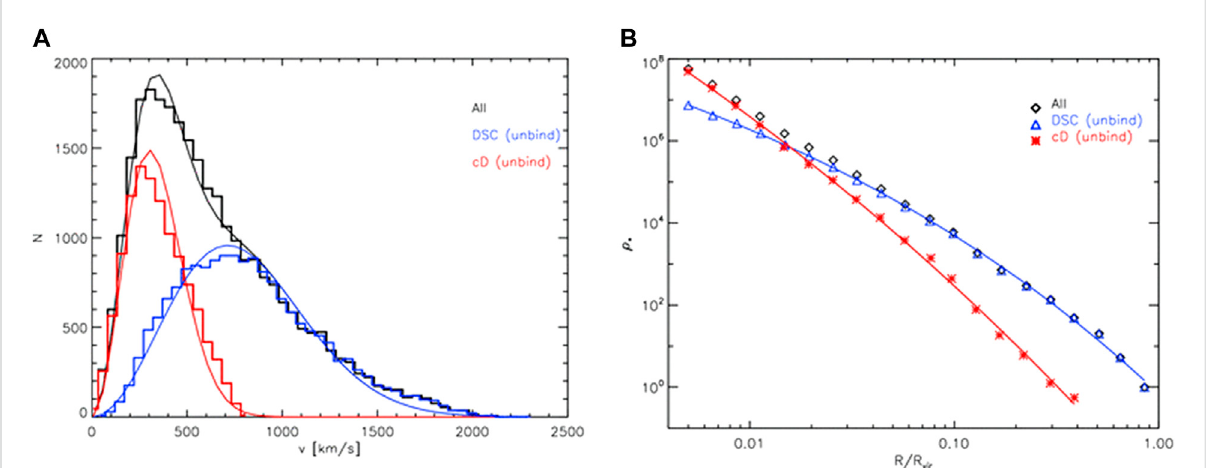
FIGURE 1 Maxwell-Boltzmann distributions of the absolute velocities of stellar particles in simulated clusters and separation of central galaxies and ICL. (A) – velocity histogram (black line) of the DSC in a simulated cluster and a double Maxwellian fi t to it (grey line) are shown. Red and blue histograms showthevelocitydistributionoftheCCGandICLstarsaftertheunbindingprocedure,togetherwiththetwoindividualMaxwelliandistributionsfrom theglobal fi t,respectively. (B) – Allstars centered onCCG (black symbols),CCG(red symbols) and ICL(blue symbols)stellardensity pro fi les. The red and blue line are Sersic fi ts to the two distributions, respectively. Image reproduced from Figure 7 and Figure 8 of Dolag et al. (2010) with